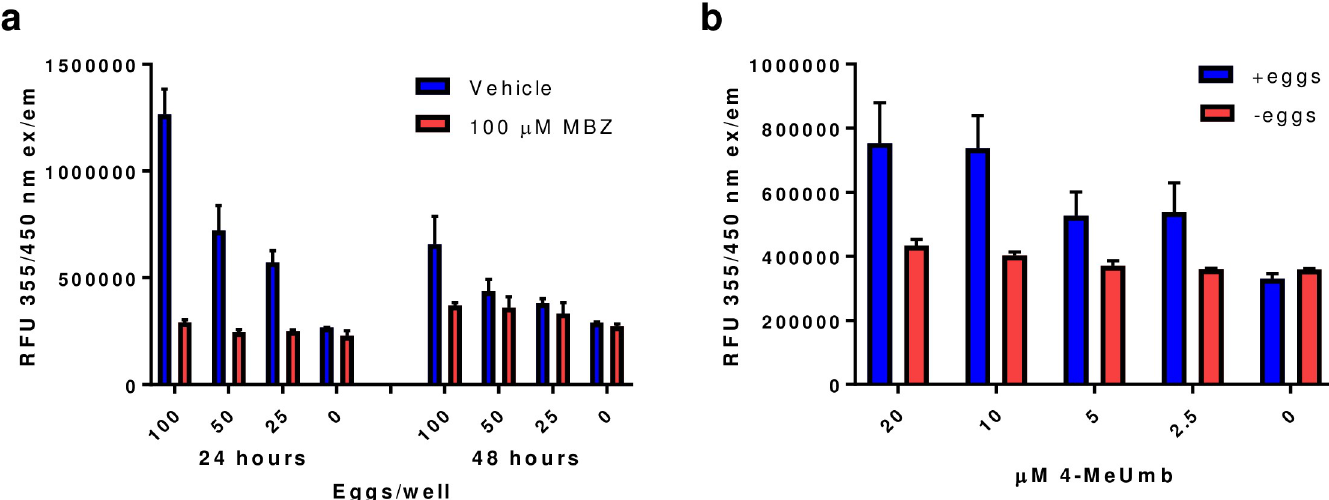
Fig 1. Assay optimization. a. Effect of A . ceylanicum egg number and mebendazole treatment time on the chitinase egg hatching assay. 100, 50, 25 and 0 eggs/well (20 μ L) were treated with 1 μ L of either 2 mM MBZ or DMSO vehicle for 24 or 48 hrs at 27˚C followed by chitinase detection with 10 μ M 4-MeUmb. b. Effect of 4-MeUmb concentration on the fluorescent signal produced by egg hatching. 20 μ L of 50 eggs/well or water was incubated for 24 hrs at 27˚C followed by chitinase detection with 20, 10, 5 or 2.5 μ M 4-MeUmb.